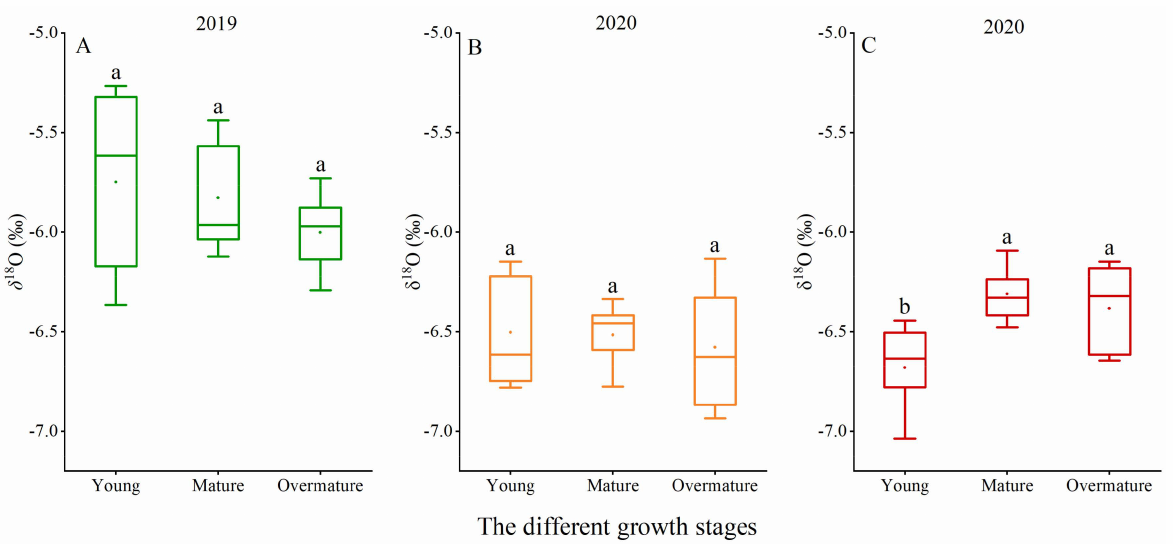
Figure 3. The δ 18 O values of xylem water for Populus euphratica Oliv. ( A , B ) and Tamarix chinensis Lour. ( C ) in 2019 and 2020. The different lowercase letters indicate significant differences at the different growth stages for a given species ( p < 0.05), n = 5.